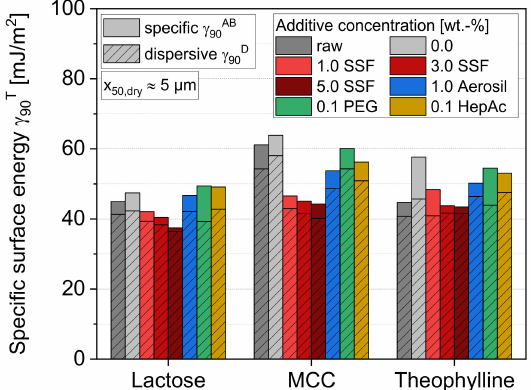
Figure 8. Impact of additive and additive concentration on the specific surface energy of raw particles and milled particles (x 50,dry approximately 5 µ m), n =